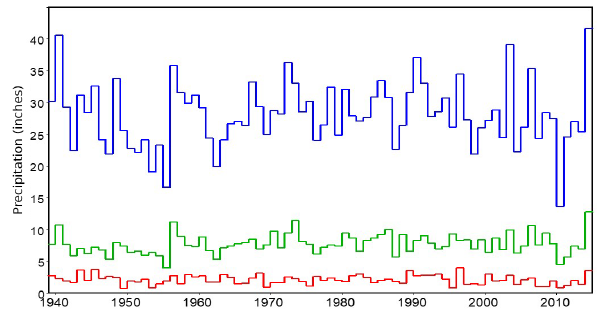
Figure 2. Statewide annual mean (top plot), two-month maximum (middle plot), and two-month minimum (bottom plot) precipitation during each year of 1940–2014.